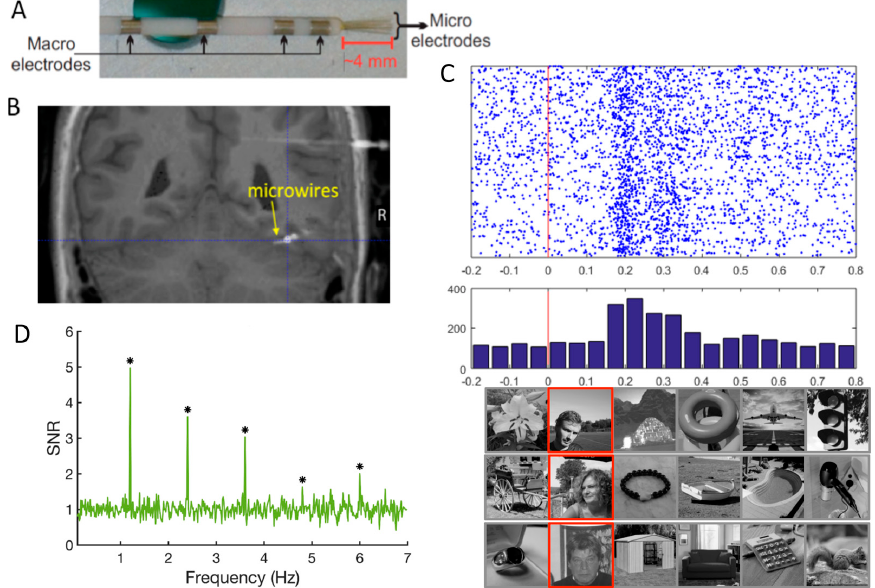
Figure 23. ( A , B ) Electrode contacts to record neuronal activity in face-selective vOTC regions, with microelectrodes at the tip of the electrode. ( C ) Selective increase in spike rates in the MidFusiform Gyrus synchronized to the onset (red vertical line) of various face stimuli (see examples in red boxes in lower panel) in a 6 Hz train of objects (1 patient, two trials of 60 s, unpublished data). Each row depicts the raster (each blue dot is a spike) of a 1 s epoch ( − 0.2 s to 0.8 s) in one of the continuous 60 s periodic stimulation, showing here an excitatory response emerging at around 150 ms post-face onset. ( D ) Frequency-domain response (green) based on the whole 60 s stimulation window shows readily quantifiable face-selective neuronal spiking activity at 1.2 Hz (with harmonics, 2.4 Hz, etc.) and a small 6 Hz response common to all stimuli. Asterisks depicts significant responses at relevant harmonics. Microelectrode-recorded signals are processed by band-pass (300–6000 Hz) non-causal filtering, threshold-based spike detection, and artifact removal. For MU activity, remaining transients are convolved by a 20 ms gaussian window, and the FFT of the resulting signal is computed in order to evaluate periodic variations of the firing rate of the neuronal population. For SU activity, spike events are clustered with sorting algorithms [260]. Single unit spike trains are convolved with a rectangular/gaussian kernel, and the FFT of this signal is then computed.